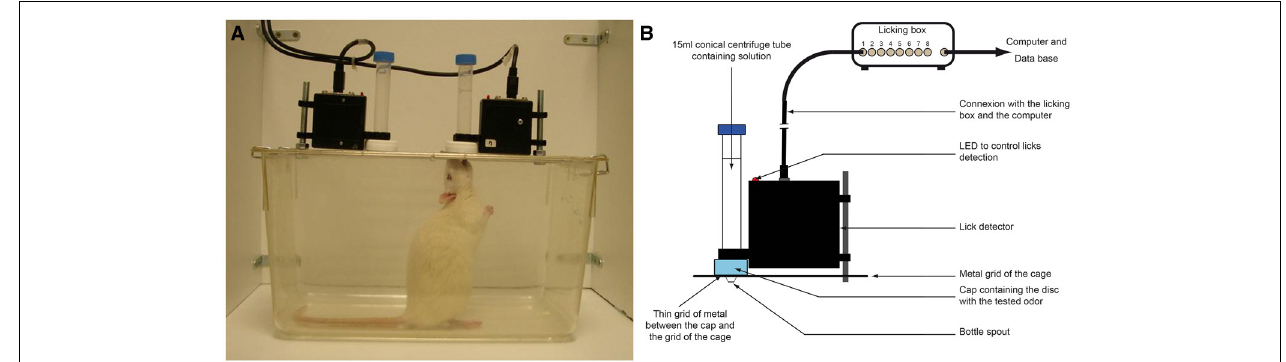
FIGURE 1 | Experimental Set-up. (A) Experimental set up. When the rat drinks, its nose is in close contact with the odor to ensure a good association with the drinking solution. The odor is never ingested. (B) Detail of the bottle and the licking box system. The tube containing the solution is coupled to a lick detector. The odor is placed on a disk into a cap face